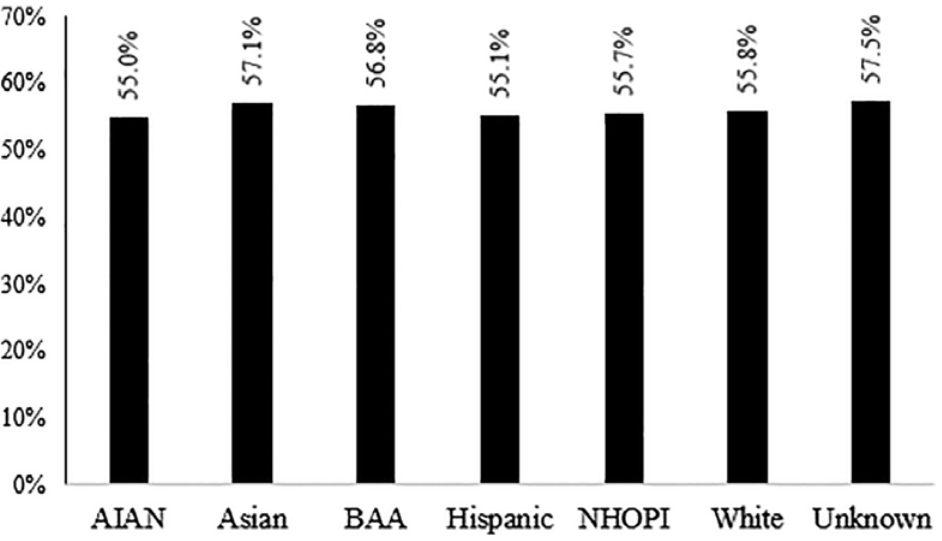
Figure 7. In Service Level Agreement Percentages by Self- Reported